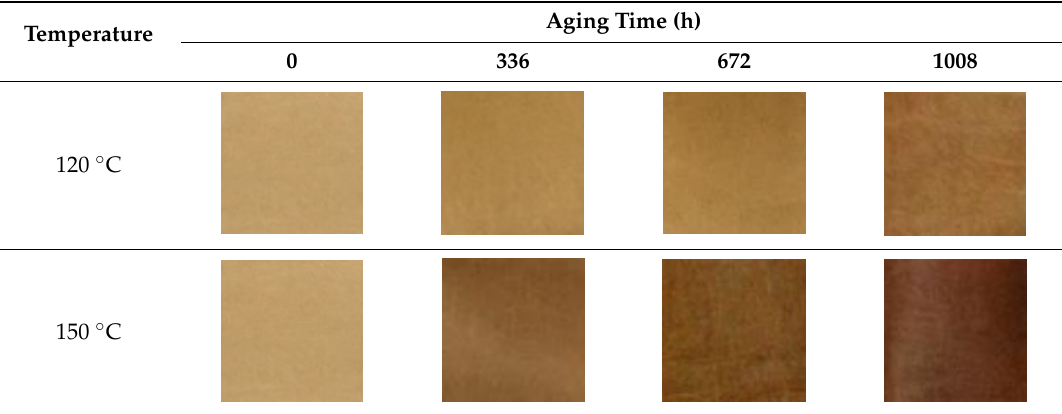
Figure 4. Correlation between DP and TS of paper samples at aging temperature ( a ) 120 °C and ( b ) 150 °C. Table 2. Visual appearances of paper surface.